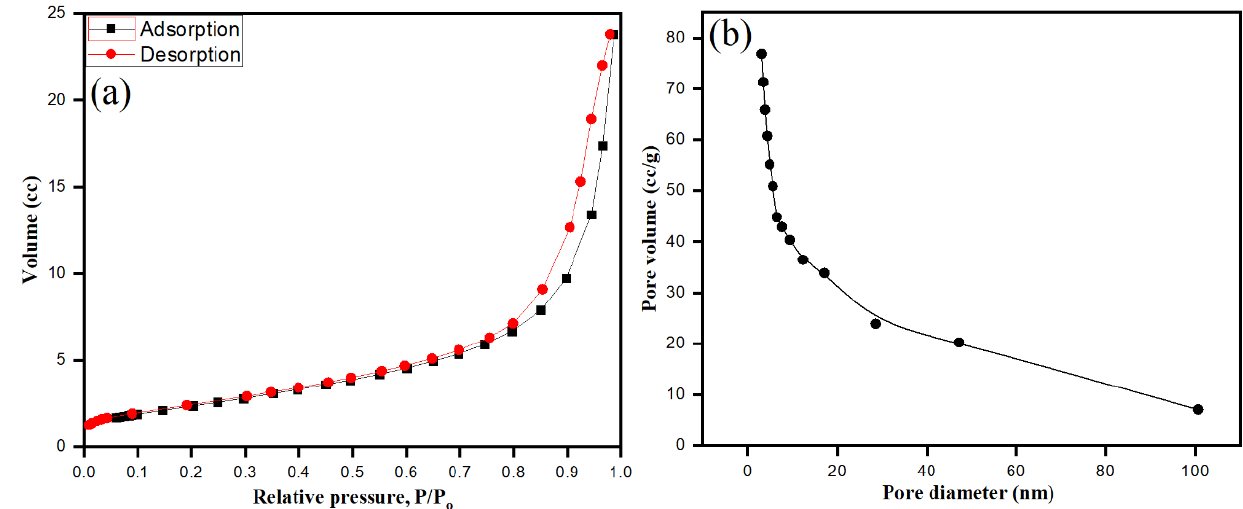
Figure 9. BET surface area nitrogen adsorption–desorption isotherms of ZnO ( a ), and pore diameter of bio-fabricated ZnONPs ( b ).